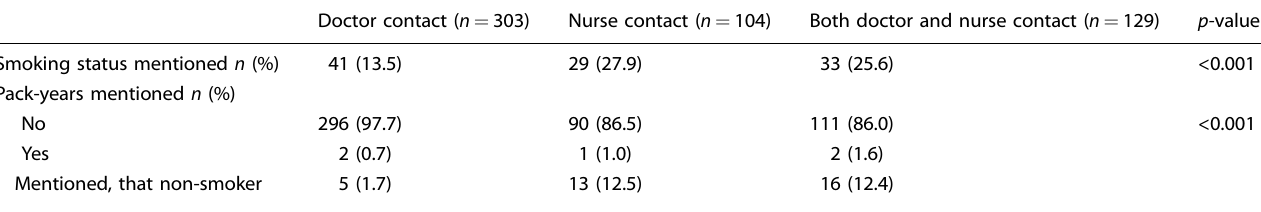
Table 2. Recording of smoking in scheduled primary health care of fi ce-based visits ( n = 536) according to the health care professional encountering the